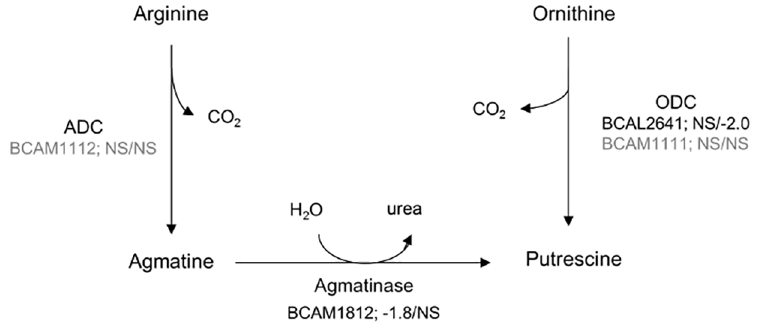
Fig 9. BH affects regulation of genes involved in putrescine biosynthesis of B . cenocepacia J2315. The reactions depicted in black are significantly (p < 0.05) differentially regulated (fold changes of “BH vs. Ctrl” / “TOB+BH vs TOB”). The enzymes involved the putrescine synthesis pathway are ornithine decarboxylase (ODC), arginine decarboxylase (ADC) and agmatinase. NS: no significant change in gene expression (p > 0.05).